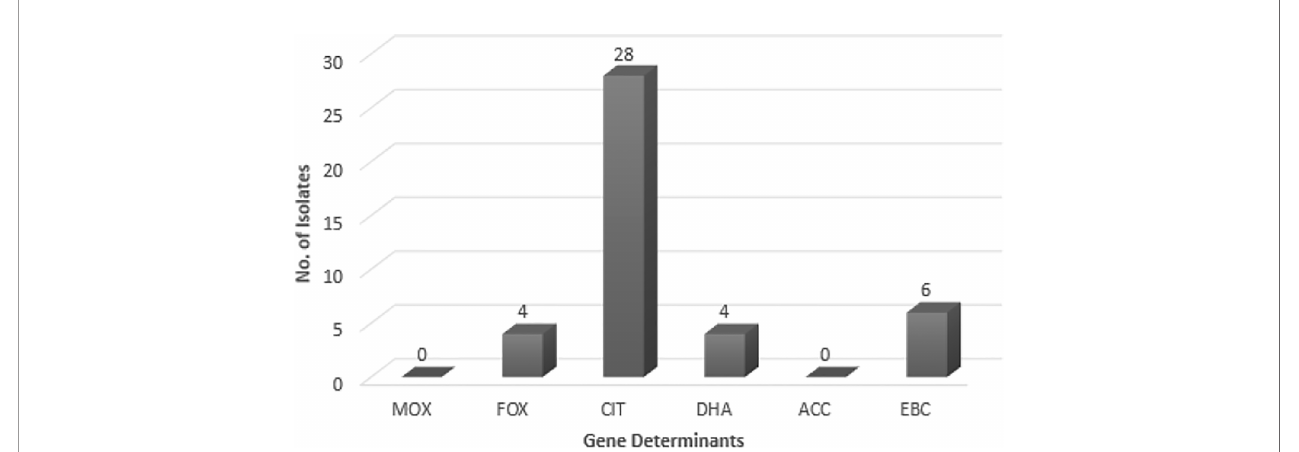
FIGURE 1 | The frequency of AmpC genes in E. coli isolates. MOX, Active on Moxalactam; FOX , Active on Cefoxitin; CIT , Firstly isolated from Citrobacter freundii ; DHA , Firstly isolated at Dhahran Hospitals in Saudi Arabia; ACC , Ambler class C; EBC , Isolated from Enterobacter cloacae